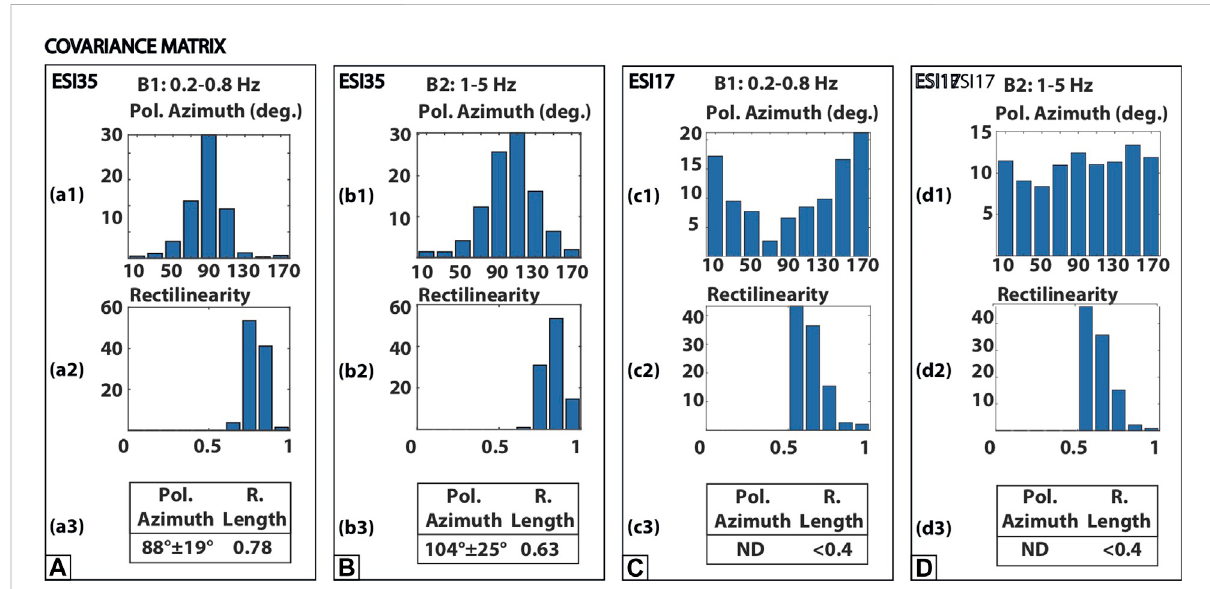
FIGURE 3 Results for ground motion polarization retrieved through the covariance matrix analysis at the two exempli fi cative stations ESI35 showing an effect, panels (A,B) ; and ESI17 not showing an effect, panels (C,D) . Polarization azimuth is de fi ned as the angle between the projection on the horizontal plane of the polarization vector and north, measured clockwise. This parameter gives a clear indication on the predominant polarization direction of horizontal ground motion (0 ° corresponds to geographic North; 90 ° and 180 ° correspond to geographic East and South, respectively).Histogramsofpolarization azimuthvaluesare obtained inthefrequencyband0.2 – 0.8 Hz(panels a1andc1)and inthefrequencyband 1 – 5 Hz (panels b1 and d1). Similarly, in panels a2, b2, c2, and d2, we also add histograms of the rectilinearity values, given by Eq. 4. This parameter rangesbetween0(puresphericalmotion)and1(purerectilinearmotion). Finally,inpanelsa3,b3,c3,andd3,weadd fi nalresultingparameters ofthe covariancematrix analysis: polarization azimuth andRL, thelatter representing theconcentration/spread of polarization azimuth distribution (Eq.